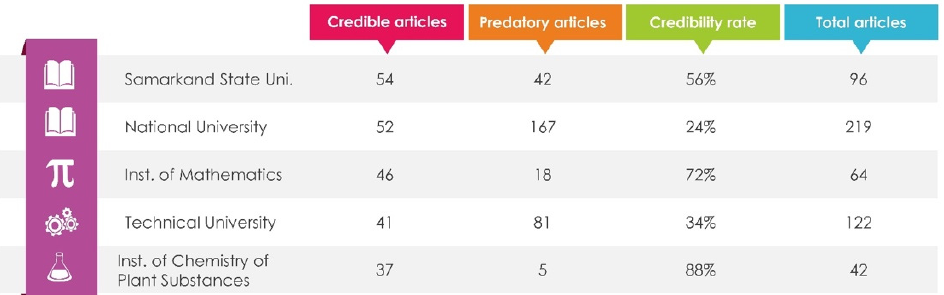
Figure 10. Top-five universities based on the number of scholarly articles.